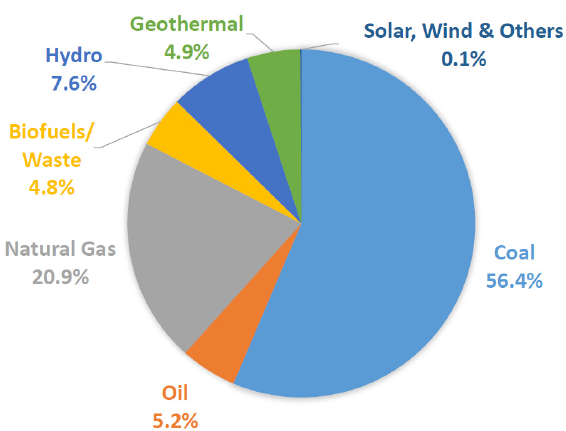
Figure 2. Total electricity supply of Indonesia in 2018 [4]. Table 2. The levelized cost of electricity of renewables and fossil-fuelled generators in Indonesia. Values for OTEC based on [20], values for all other technologies based on [21].